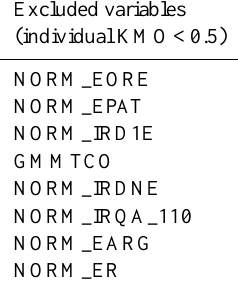
Table 3. Excluded variables due to low individual KMO values (<0.5) taken from the diagonal of the anti-image correlation ma-